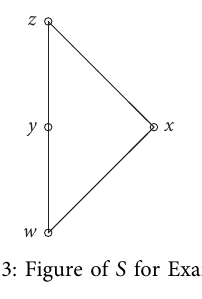
Figure 3: Figure of S for Example